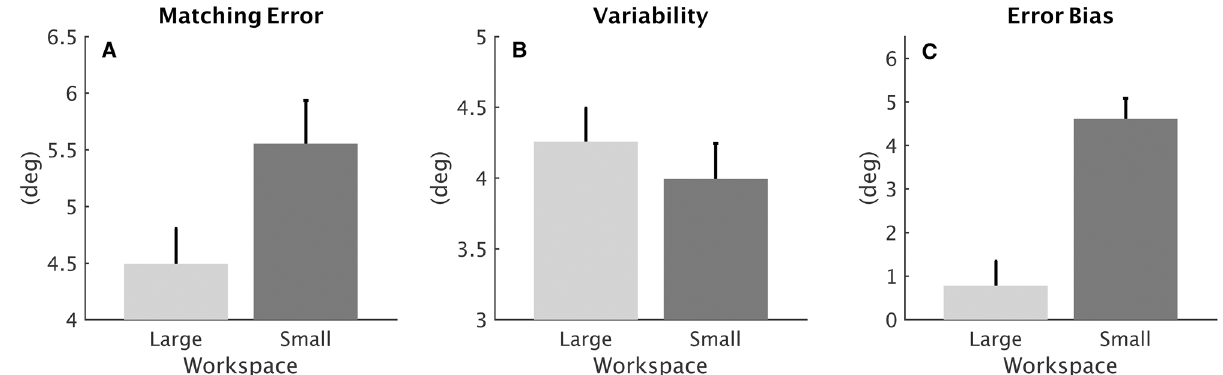
Fig 4. Overall difference, of the three DoFs, between performance in the large (LWS) and in the small (SWS) workspace for matching error (A), variability (B) and error bias (C).